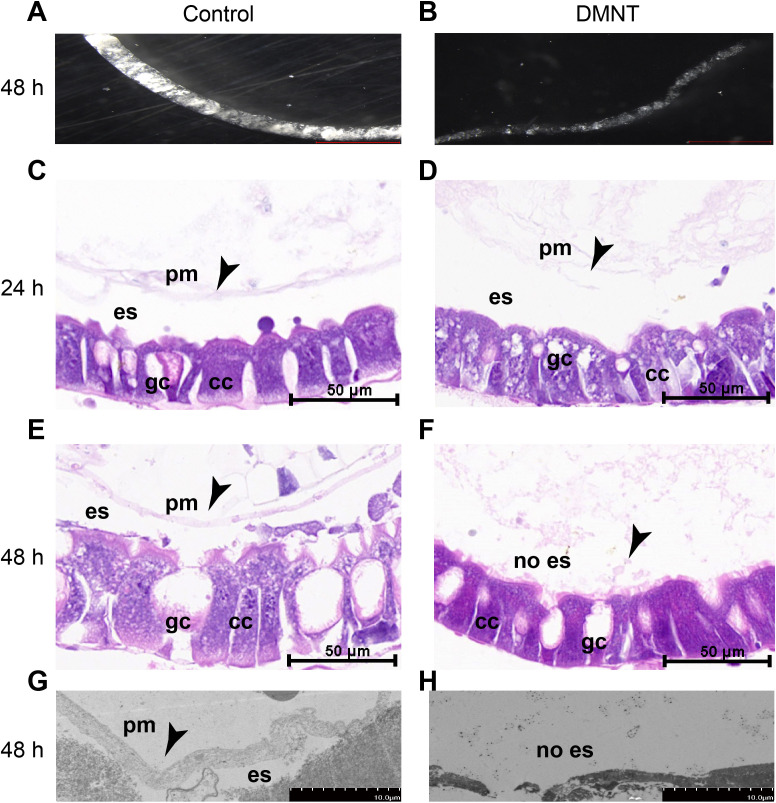
The peritrophic matrix (PM) structure is damaged by (3E)-4,8-dimethyl-1,3,7-nonatriene (DMNT) treatment.(A, B) PM ultrastructure of control (A) and DMNT-fed (B) P. xylostella larvae for 48 hr. Note the thin and delicate PM in DMNT-fed larvae. (C–F) Transverse section and hematoxylin-eosin staining show damage of the PM by DMNT after exposure for 24 hr (C, D) and 48 hr (E, F). (G, H) The PM is damaged by DMNT feeding, as shown by transmission electron microscopy. Arrowheads indicate the PM. es: delimits the ectoperitrophic space; gc: goblet cells; cc: columnar cells.
Figure 3—source data 1.The peritrophic matrix (PM) structure is damaged by (3E)-4,8-dimethyl-1,3,7-nonatriene (DMNT) treatment.